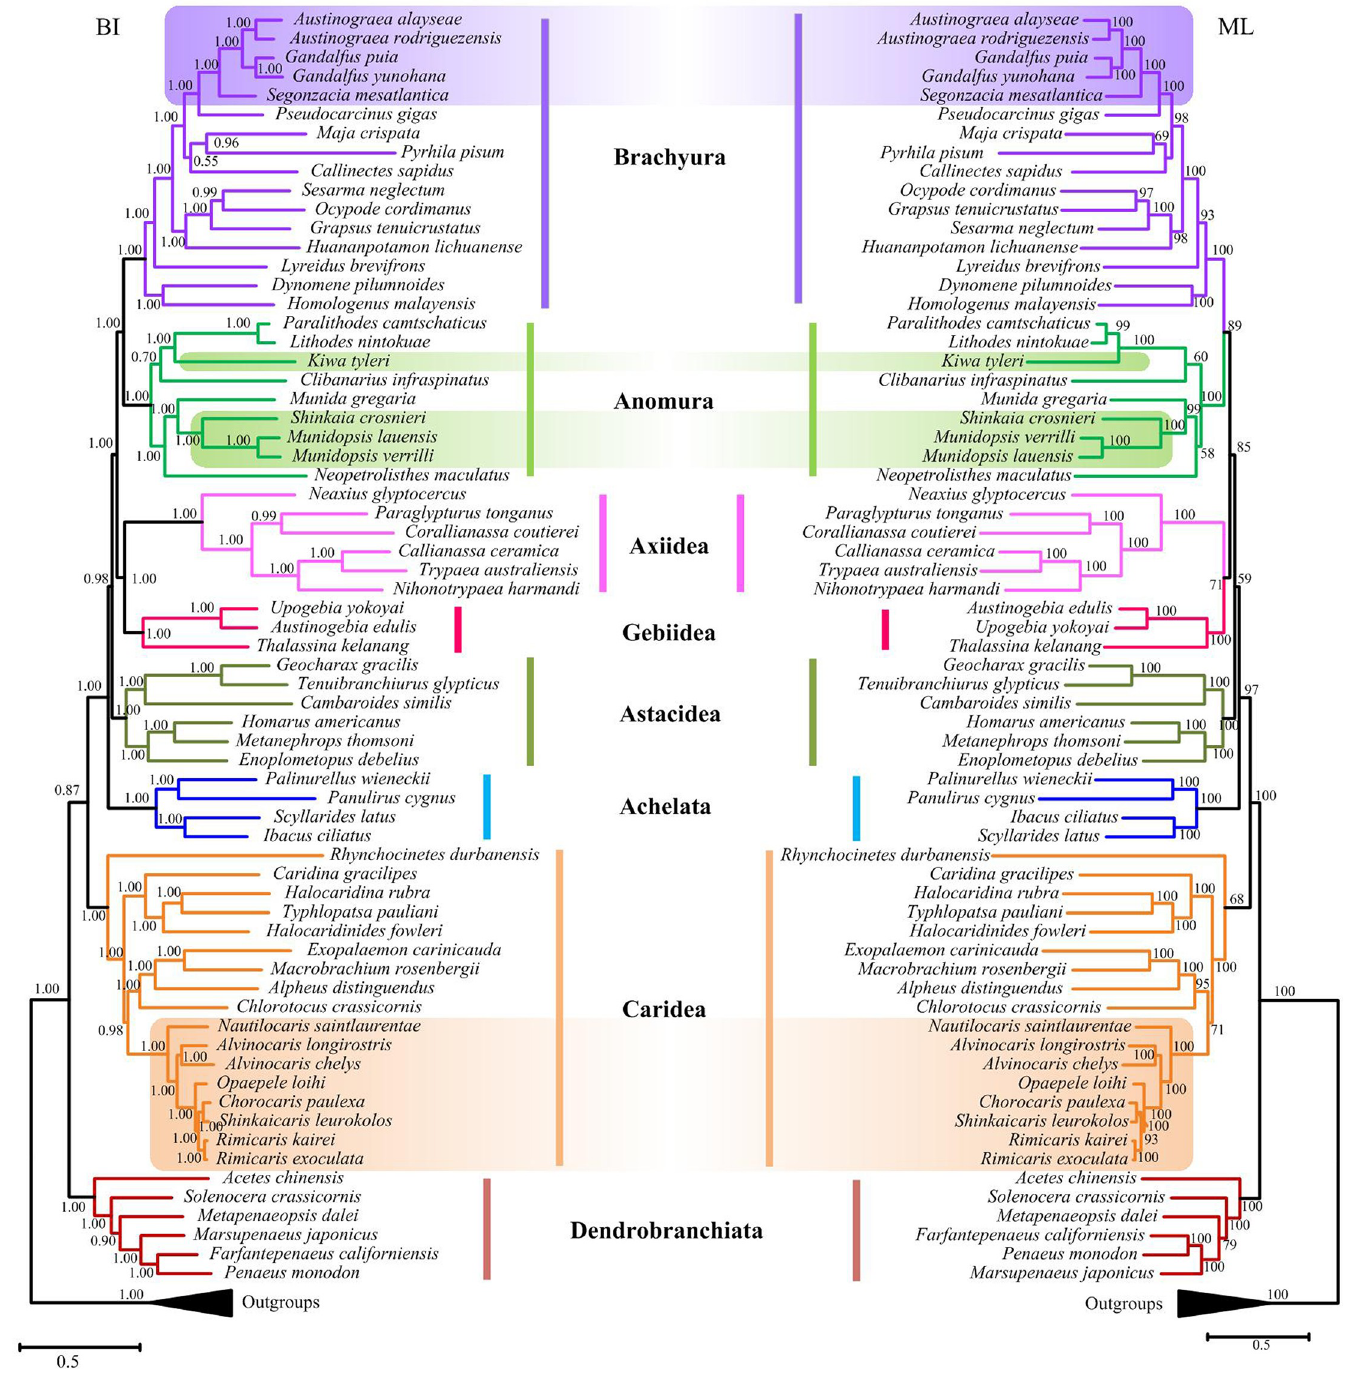
Fig 2. Phylogenetic trees of Decapoda derived from Maximum Likelihood (ML) and Bayesian analyses (BI) based on nucleotide sequences of 13 mitochondrial PCGs. The number at each node is the bootstrap probability (ML) and Bayesian posterior probability (BI). The purple, green and orange backgrounds indicate hydrothermal vent bythograeid crabs, galatheid squat lobsters and alvinocarid shrimps, respectively.